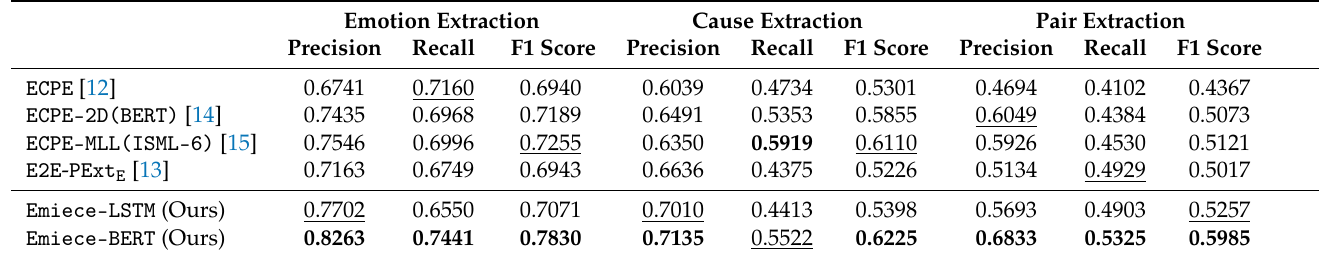
Table 3. Best results of our model and previous experimental methods with existing metrics after hyper-parameter tuning. Bold fonts indicate the best results for the method, and underlining stands for the second best results. The top half is the performance of pipelines, and the bottom half is the one of our